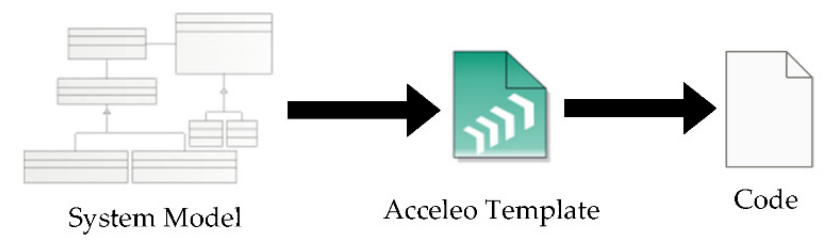
Figure 7. Acceleo operation principle.